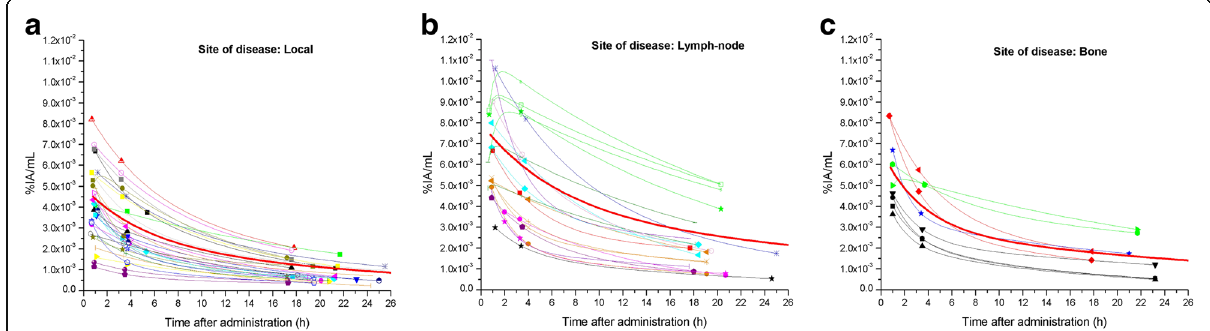
Fig. 1 PVE corrected time-activity curves of 64 CuCl 2 (as a percentage of injected activity/mL) for the three different site of disease: local ( a ), lymph node ( b ) and bone ( c ) (in red the mean